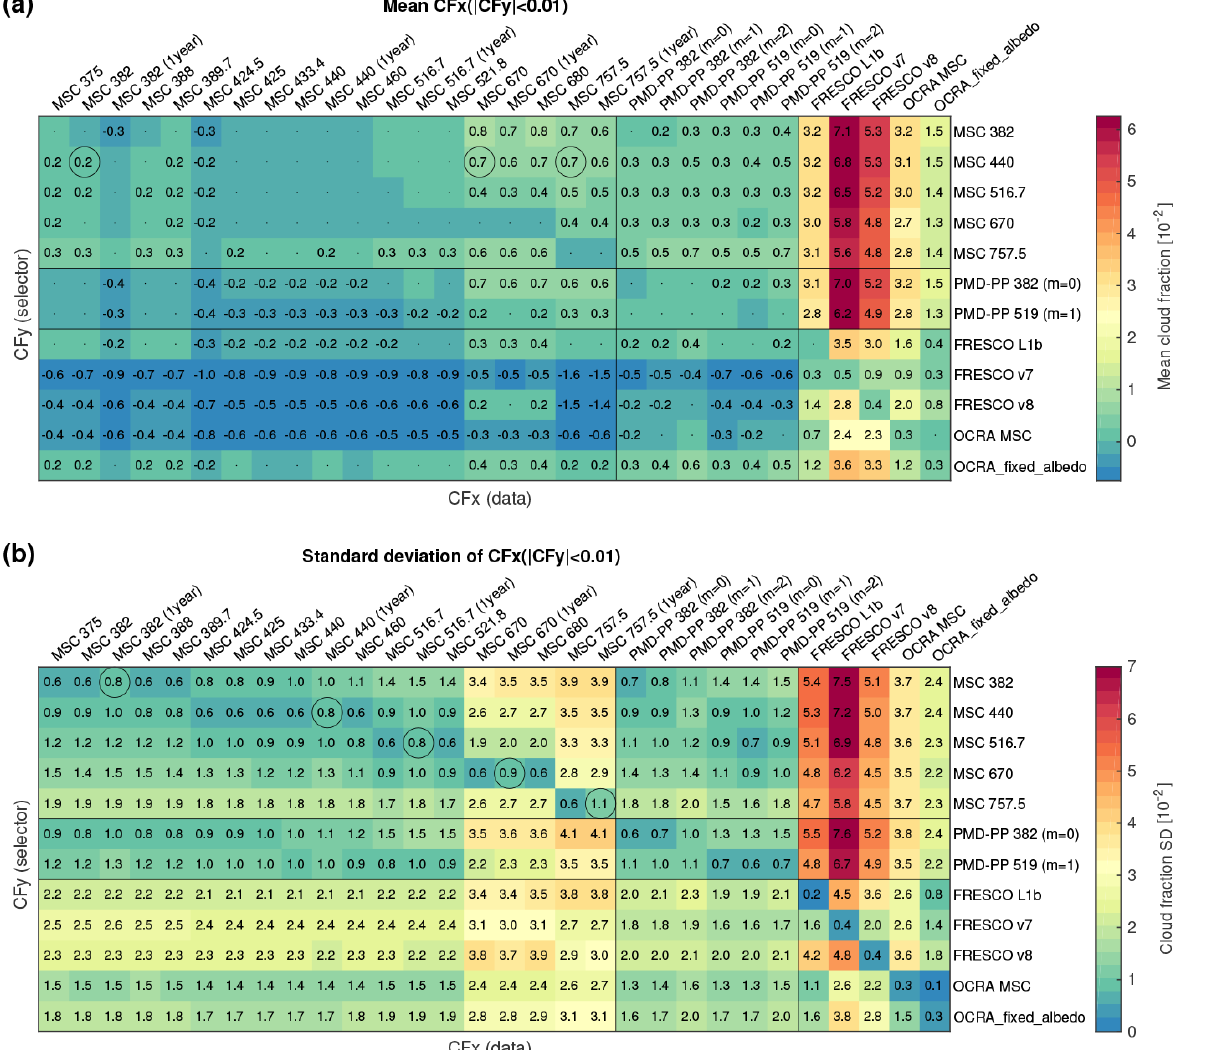
Figure E1. Tabular intercomparison of MICRU and external cloud fraction results for April 2010: (a) mean CF of product listed in the x direction selected by corresponding product in the y direction with an absolute CF < 1%; (b) same as panel (a) but listing the standard deviation. The circled values in panel (a) correspond to Fig. 15. The circled values in panel (b) indicate values comparing data of the same MICRU channel but different evaluations periods: 1 year vs. the standard data set applying 7 +